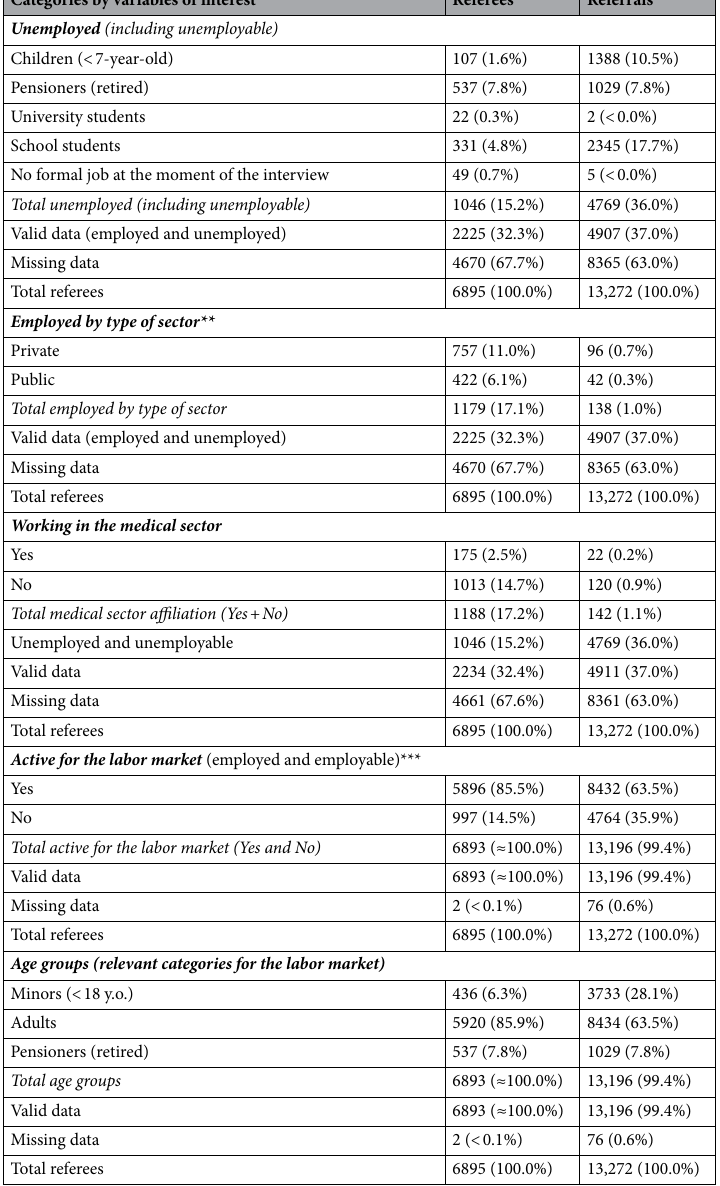
Table 1. Descriptive statistics for variables used in the statistical modelling. *Within a total of 20,167 unique cases (6895 referees and 13,272 referrals), 7130 are unique cases with full information (2223 referees and 4907 referrals) on the variables of interest (age, sector, medical sector affiliation, and status on the labor market). ** Public = state-owned organizations, Private = private companies. *** Employable = not working but eligible to